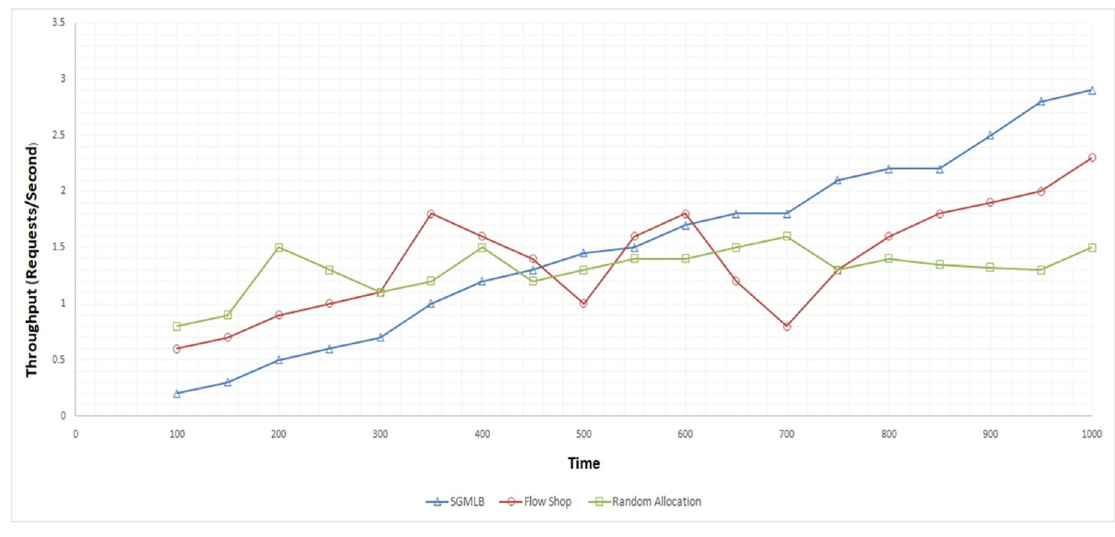
Fig 5. Throughput